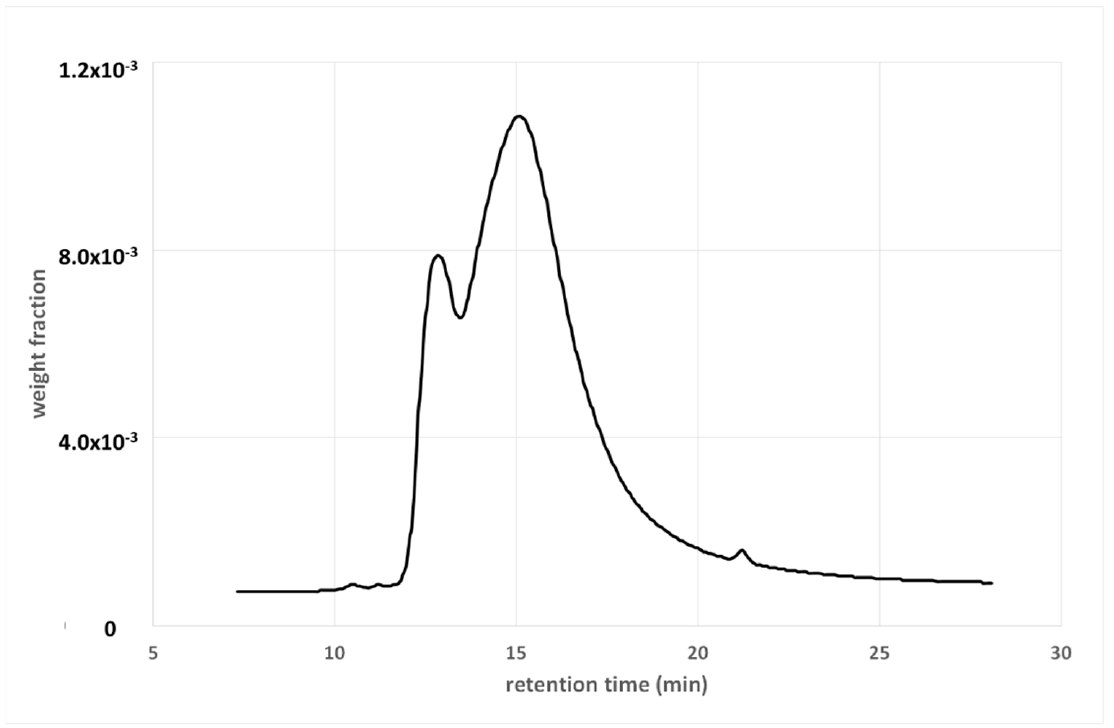
Figure 10. Weight fraction as a function of retention time of a PMB containing 6% SBS. Details on the materials and procedures are given in [39].